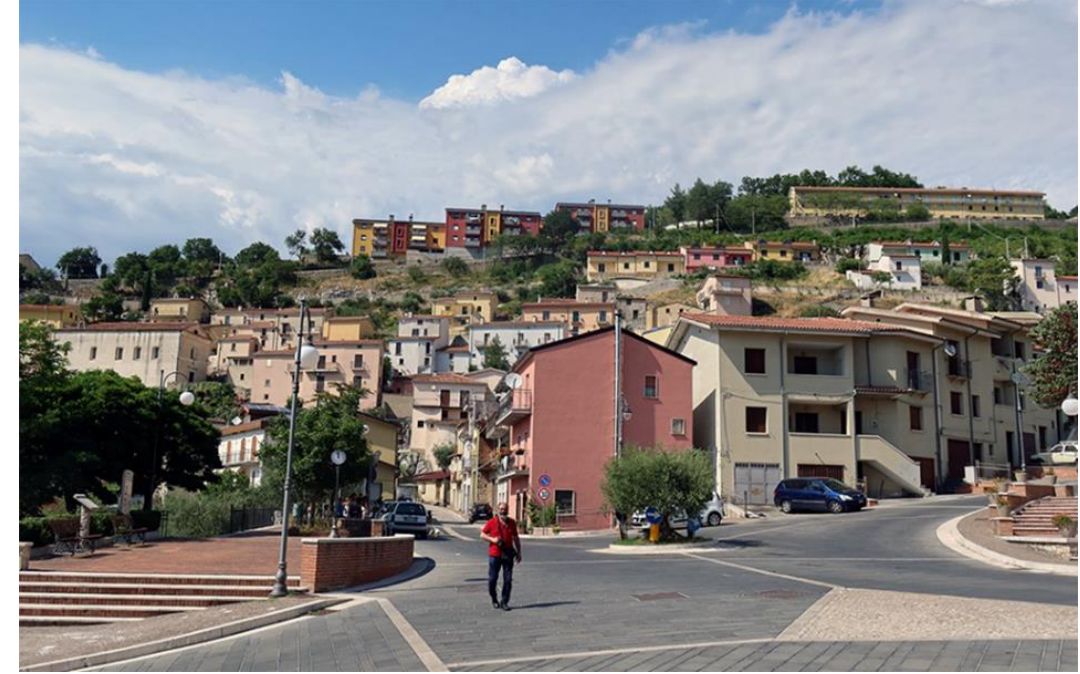
Figure 30. Santomenna: the center of the village completely rebuilt (photos by [35,36]).